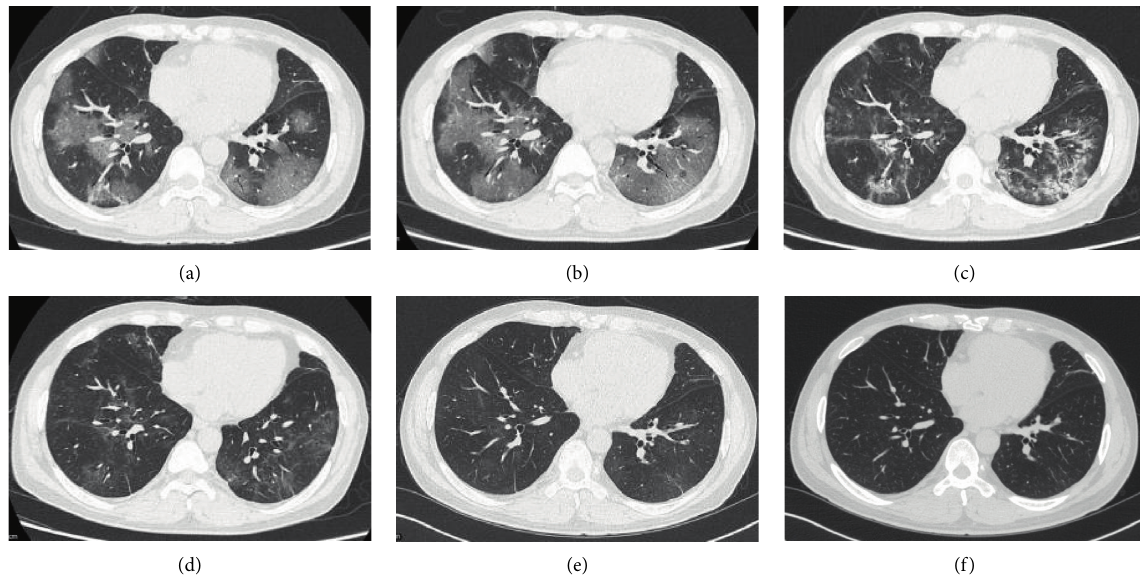
Figure 2: A 46-year-old male patient with severe coronavirus disease 2019. (a) On the seventh day after onset, multiple ground-glass opacities were detected in both lungs. (b) On the ninth day after onset, the distribution of ground-glass opacities in both lungs was wider than before. (c) On the 18 th day after onset, some lesions in both lungs became smaller and were absorbed, while the local density increased. (d) On the 34 th day after onset and 2 days before discharge, the lesions were significantly absorbed in both lungs. (e) One month after discharge, light ground-glass opacities and linear opacities were visible in both lungs. (f) Six months after discharge, thin linear opacities were still visible in both lungs. Table 6: Semiquantitative visual score of lung lesions in moderate and severe patients. Group Score of the right lung